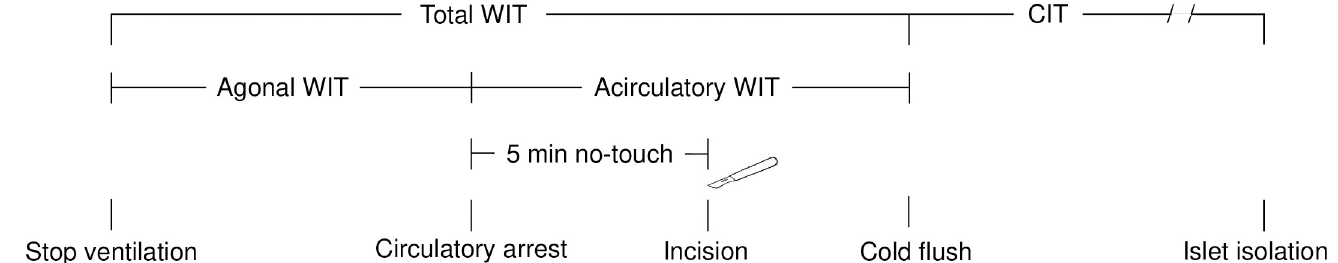
Fig 1. Definition of warm and cold ischemia times in donation after controlled circulatory death. Total warm ischemia time (WIT) represents the time between withdrawal of mechanical ventilation and abdominal aorta cannulation with initiation of cold preservation. It consists of an agonal phase (time between withdrawal of mechanical ventilation and circulatory arrest) and an acirculatory phase (time between circulatory arrest and abdominal aorta cannulation with initiation of cold flush). Cold ischemia time (CIT) starts with aortic flush using cold preservation solution and ends at start of islet isolation procedure. Pancreatectomy time is the time between cannulation and the moment the pancreas is preserved on ice outside the